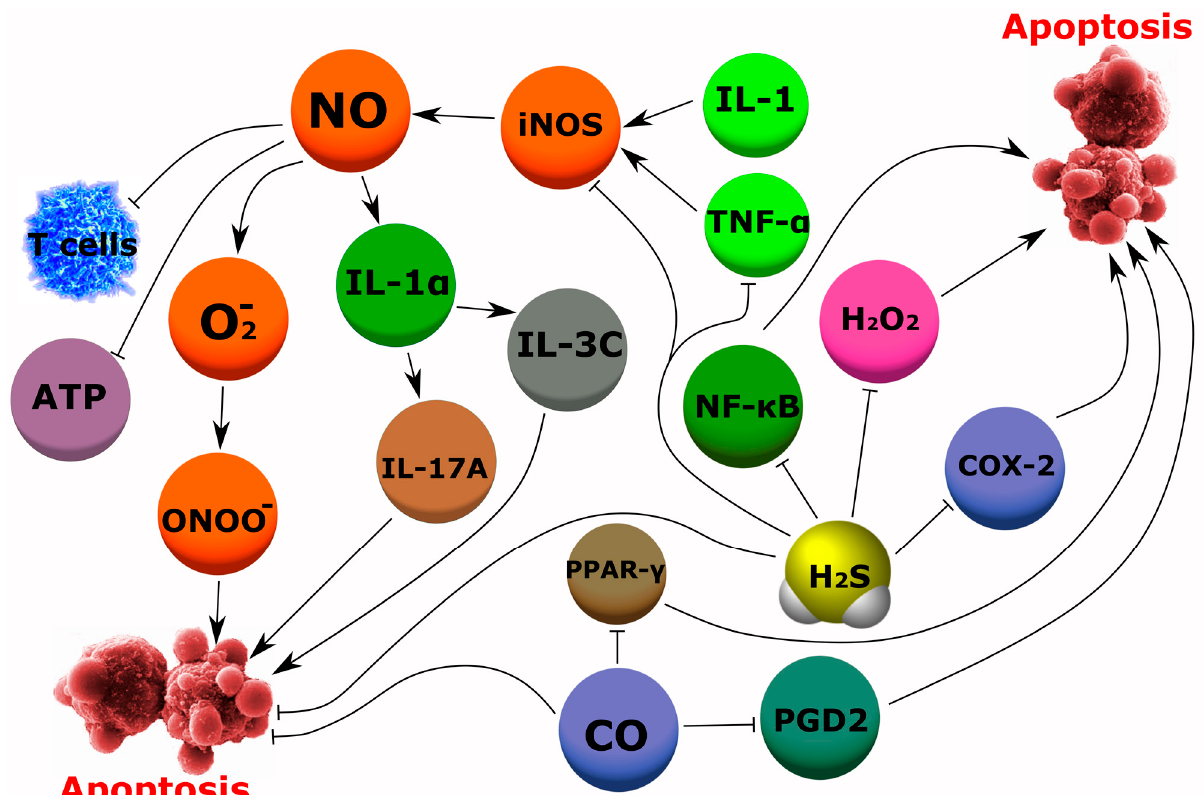
Figure 7. Possible gasotransmitter-dependent signaling mechanisms regulating apoptosis in diseases of the musculoskeletal system. NO, nitric oxide; CO, carbon monoxide; H 2 S, hydrogen sulfide; iNOS, inducible NO-synthase; ATP, adenosine triphosphate; T cells, lymphocytes; interleukins, IL-1 α , IL-17A, and IL-3C; TNF- α , tumor necrosis factor alpha; O 2 − , superoxide anion radical; ONOO − , peroxynitrite; NF- κ B, nuclear factor kappa-light-chain-enhancer of activated B cells; H 2 O 2 , hydrogen peroxide; COX-2, cyclooxygenase-2; PGD2, prostaglandin D2; PPAR- γ , peroxisome proliferator-activated receptor gamma. Arrows with a sharp end—positive regulation; arrows with a blunt end—negative regulation.